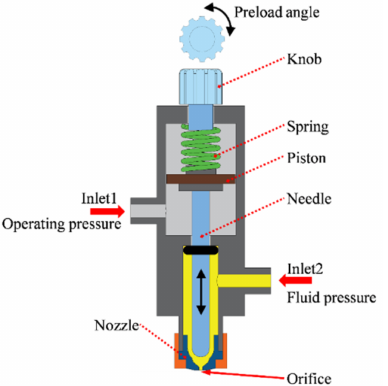
Figure 2. Schematic illustration of the pneumatic needle jetting valve.